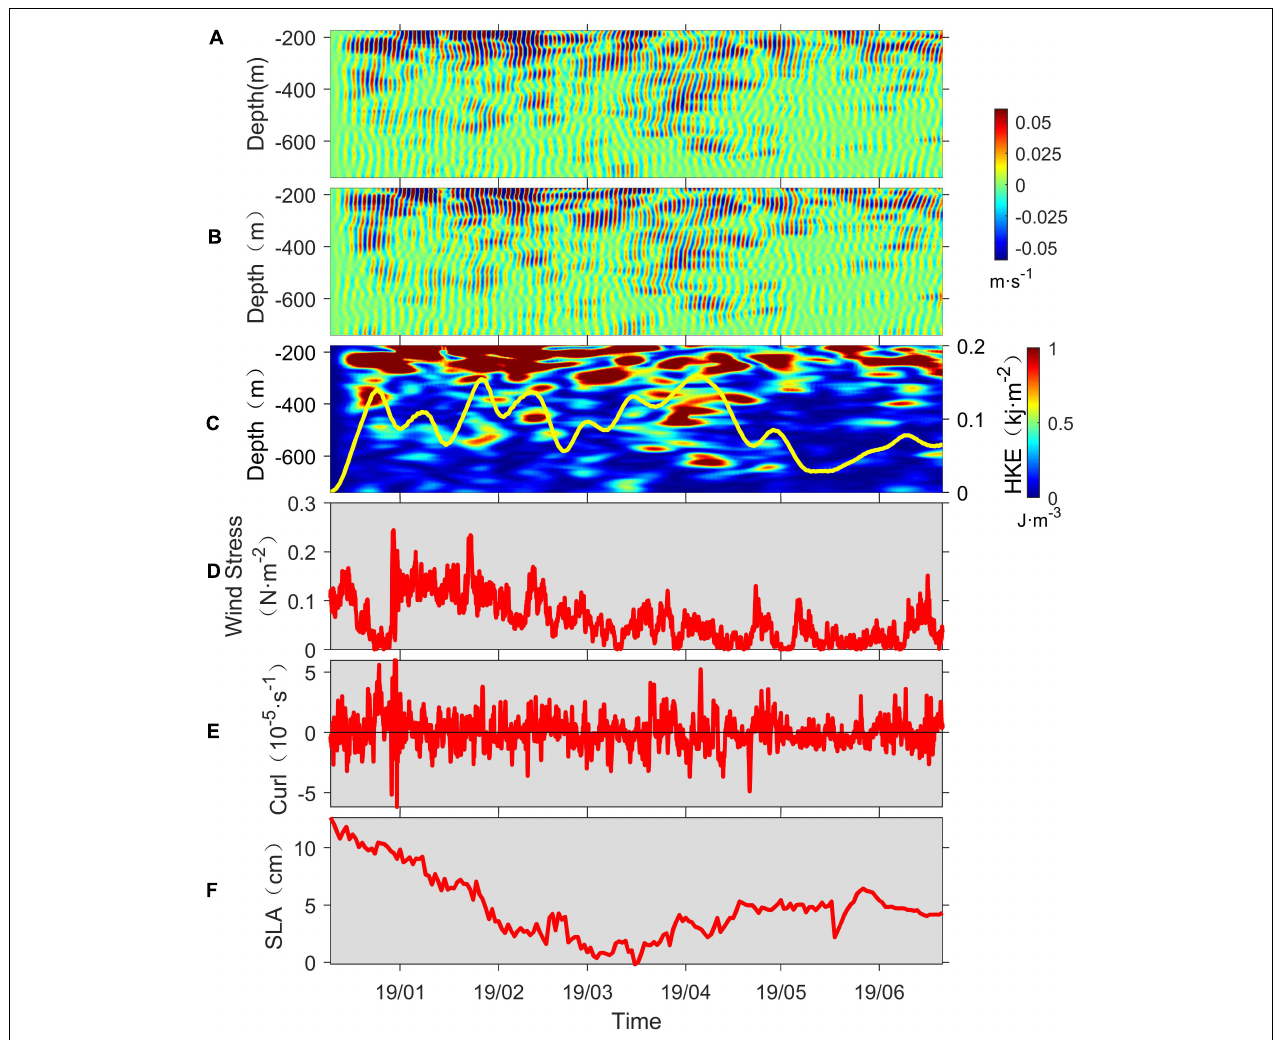
FIGURE 9 | Time series of the WKB-scaled meridional velocity of NIWs (A) and WKB-scaled zonal velocity of NIWs (B) . Distribution of WKB-scaled NIWs HKE (C) , yellow line for vertical integration. Time series of wind stress (D) , wind stress curl (E) , and SLA (F) . Horizontal labels mark the start of the month.